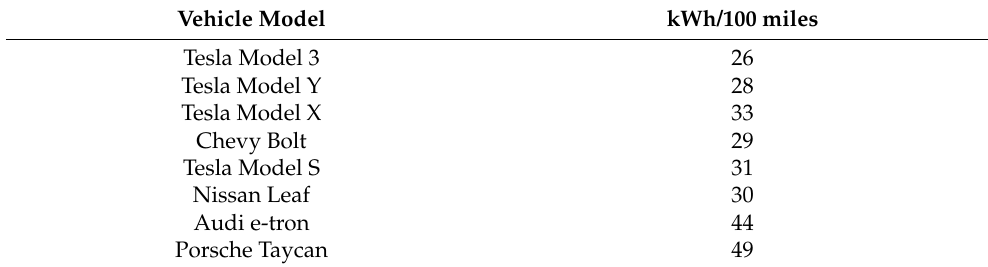
Table 3. Plug-in vehicle fuel